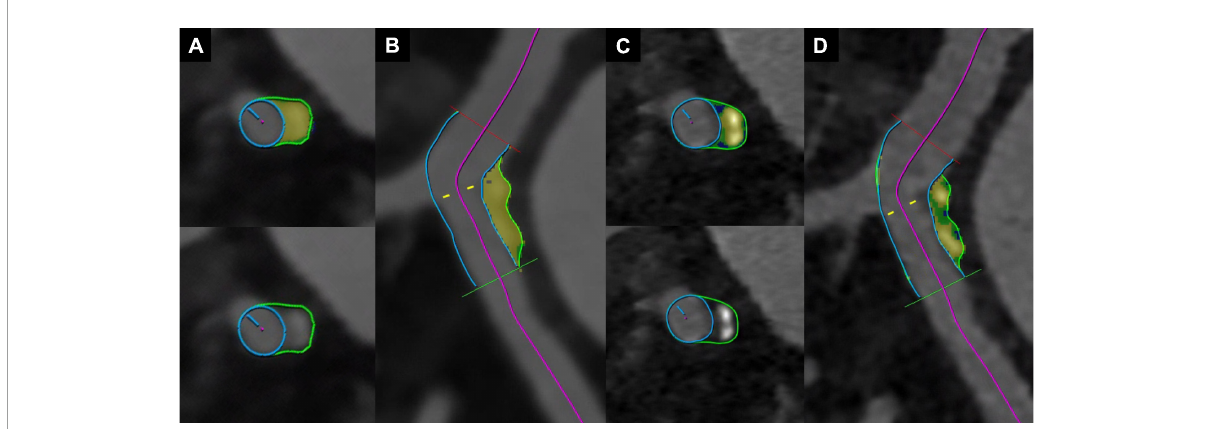
FIGURE3 Coronary CT angiography with photon-counting detector CT of an 88-year-old male patient. Images show a mixed plaque reconstructed with a slice thickness of 0.6 mm and the Bv40 kernel (A,B) , and with a slice thickness of 0.2 mm and the Bv64 kernel (C,D) . Note the improved visualization of non-calcified components (blue color corresponds to lipid rich components, green color to fibrotic components, and yellow color to calcified components) at a slice thickness of 0.2 mm with the Bv64 kernel (C,D)